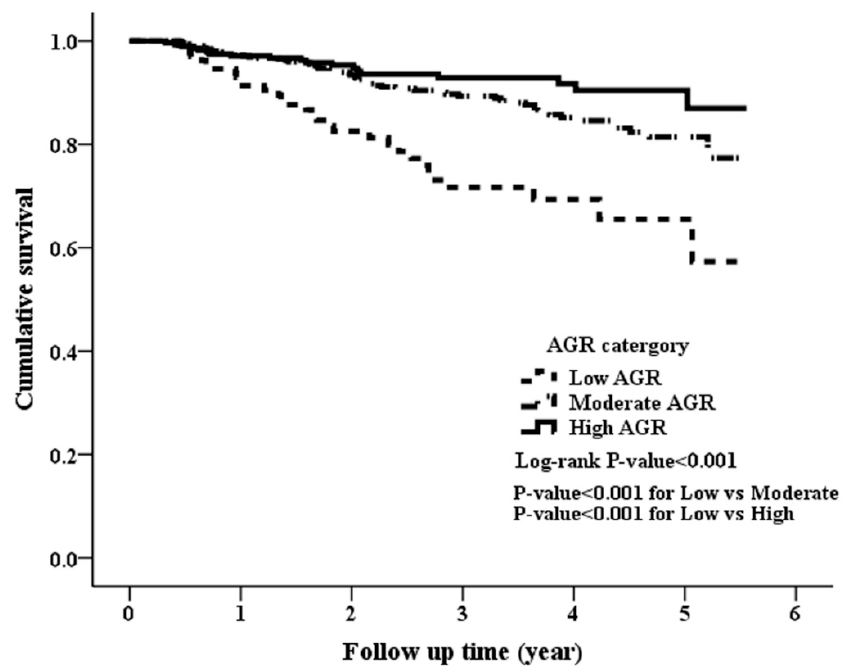
Figure 1. Kaplan-Meier curve of overall patient survival according to the AGR groups (log-rank test, p < 0.001). p <